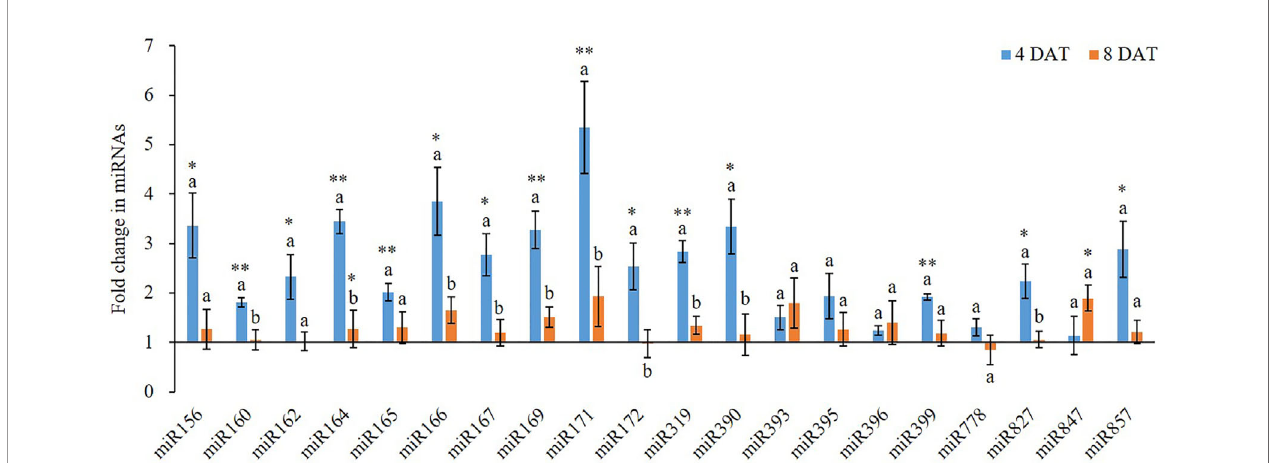
FIGURE 2 | Fold change of miRNA expression between low K + treatment and the controls at 4/8 days after transfer day (DAT). Error bars represent the S.E (n = 3). The * and ** on the bars indicate signi fi cant differences of fold change of miRNA expression between low K + treatment and the controls at 4 and 8 DAT at p < 0.05 and p < 0.01, respectively. The different letters on the bars indicate signi fi cant differences of fold change of miRNA expression between 4 and 8 DAT according to the LSD test (p = 0.05).